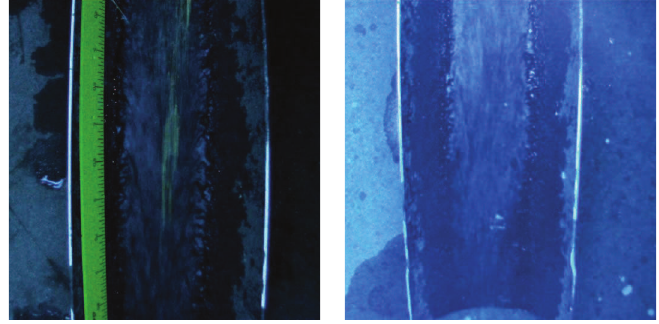
Figure 6. Left, picture of the visibility test conducted in the afternoon at H = 70 cm , v = 2 m / s , Full HD resolution, and without filter. Right, picture of the visibility test conducted at night at H = 70 cm , v = 2 m / s , Full HD resolution, and without